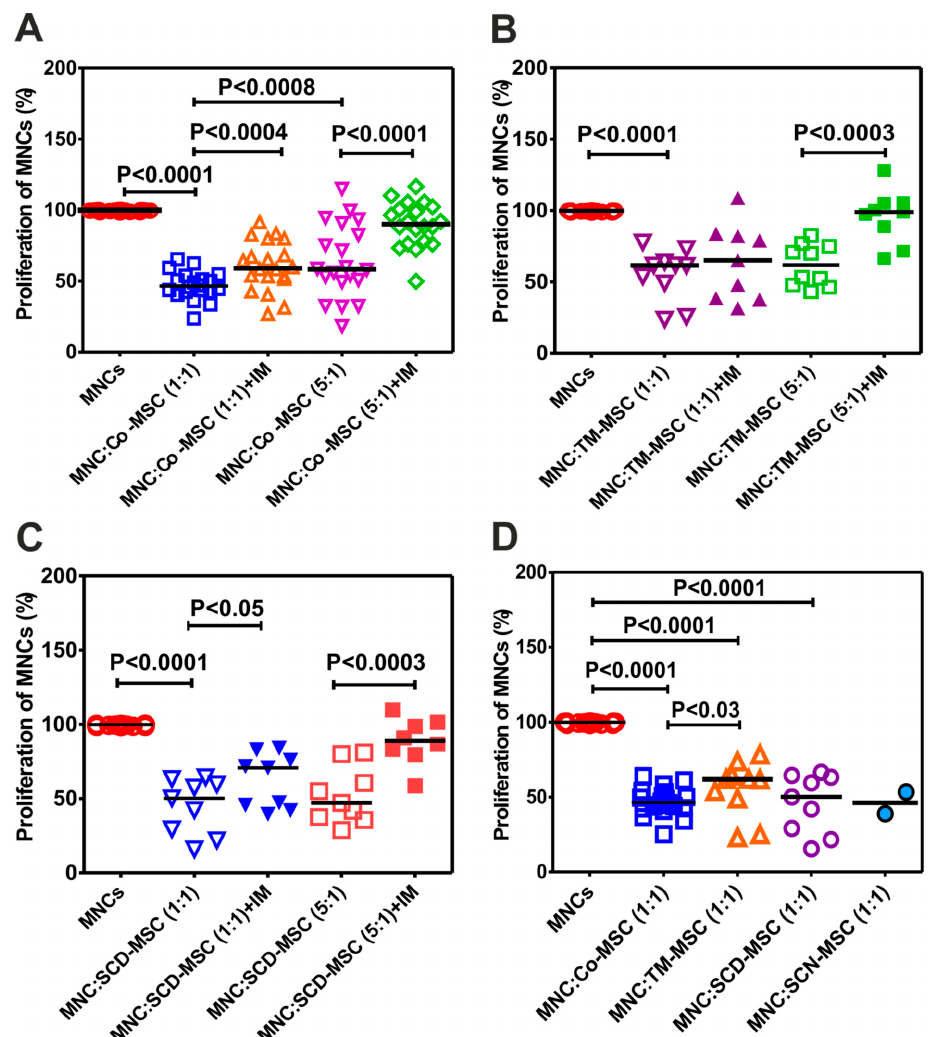
Figure 4. Immunosuppressive potential of MSCs from patients with NMHD and healthy donors ( A ) Healthy donor MSCs at different ratios with allogeneic MNCs (1:1 and 1:5) and the effect of indomethacin. ( B ) Inhibitory effect of MSCs from thalassemic patients. ( C ) inhibitory effect of MSCs of patients with SCD and ( D ) MSCs of patients with NMHD compared to control MSCs (only ratio 1:1) Differences between the groups were considered as statistically significant when P ≤ 0.05. Co: Control, TM: thalassemia major, SCD: sickle cell disease, SCN: severe congenital neutropenia.